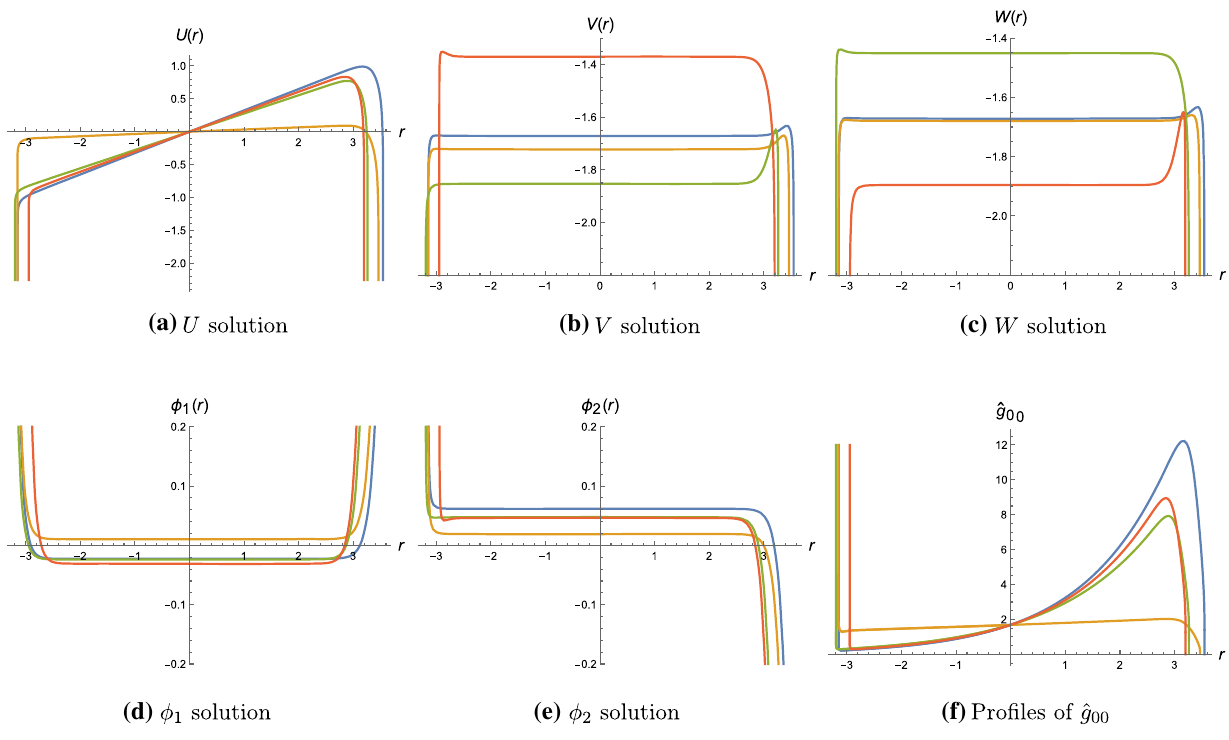
Fig. 18 RG flows between AdS 3 × S 2 × S 2 fixed points and curved domain walls for SO ( 2 ) × SO ( 2 ) twist in SO ( 3 , 2 ) gauge group. The blue, orange, green and red curves refer to ( z 1 , z 2 ) = ( − 0 . 55 , − 0 . 55 ),( − 0 . 55 , − 0 . 6 ),( − 0 . 35 , − 0 . 87 ),( − 1 , − 0 . 3 ) ,